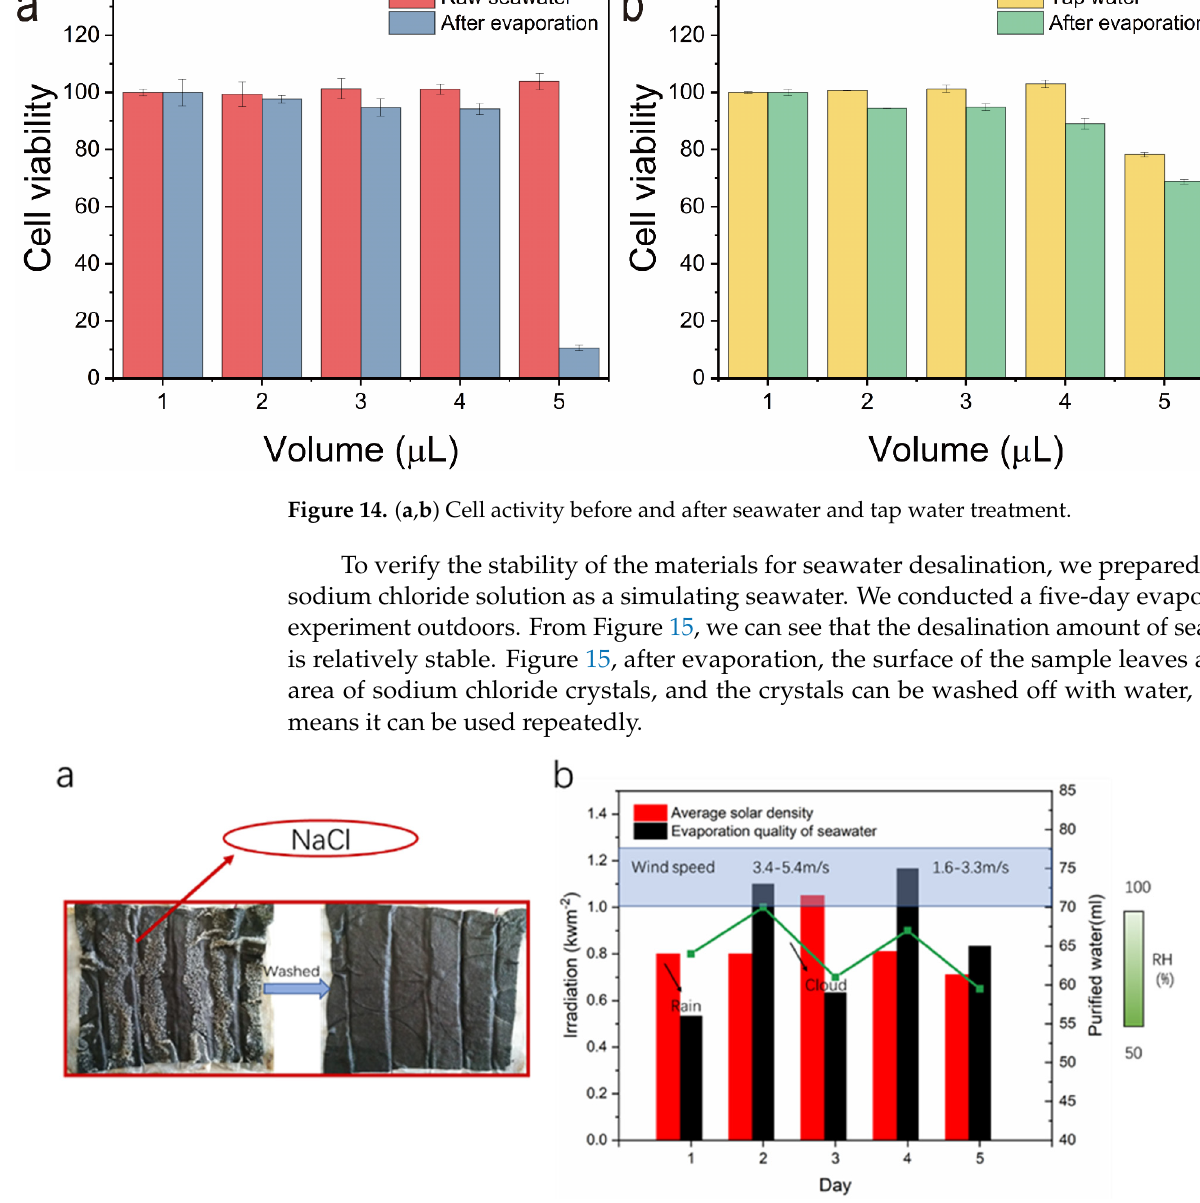
Figure 15. ( a ) A photograph of the surface of the sample after simulating seawater evaporation. ( b ) Cycle days of seawater evaporation. The red column represents the average optical density of sunlight. The black column represents the evaporation quality of water in the afternoon. Green dotted line diagram represents daily air humidity. Blue wireframe represents wind speed.